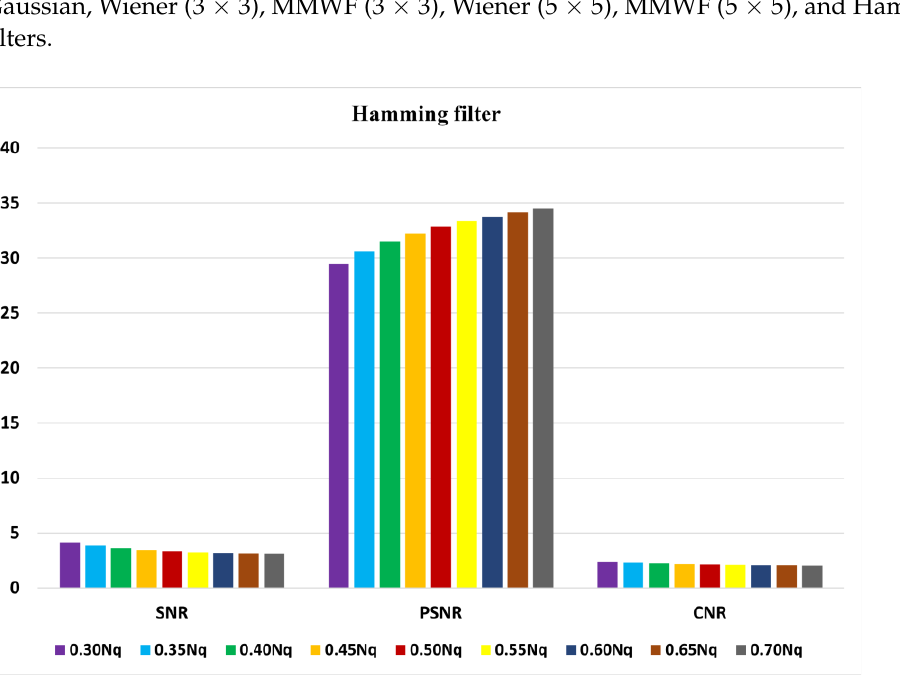
Figure 5. Graph of average of signal-to-noise ratio (SNR), peak signal-to-noise ratio (PSNR), and contrast-to-noise ratio (CNR) using the Hamming filter.